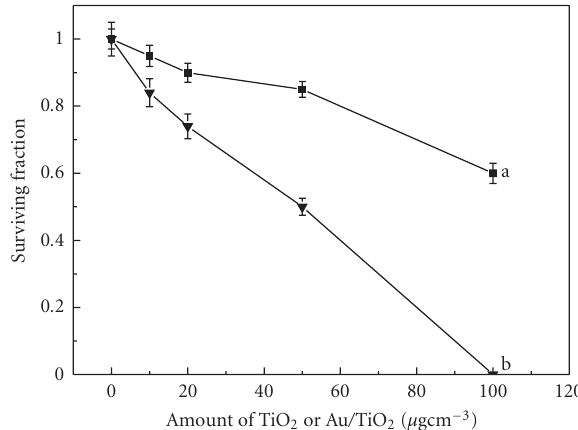
Figure 5: Surviving fraction of LoVo cells measured after the irra- diation of UV light for 60 min as a function of concentration of (a) TiO 2 nanoparticles and (b) 2wt% Au / TiO 2 nanocomposites. The wavelength of UV light is 365nm, and the intensity is 1.8 mW/cm 2 . Bars represent the region of measured data and the points represent the mean value from three measurements.